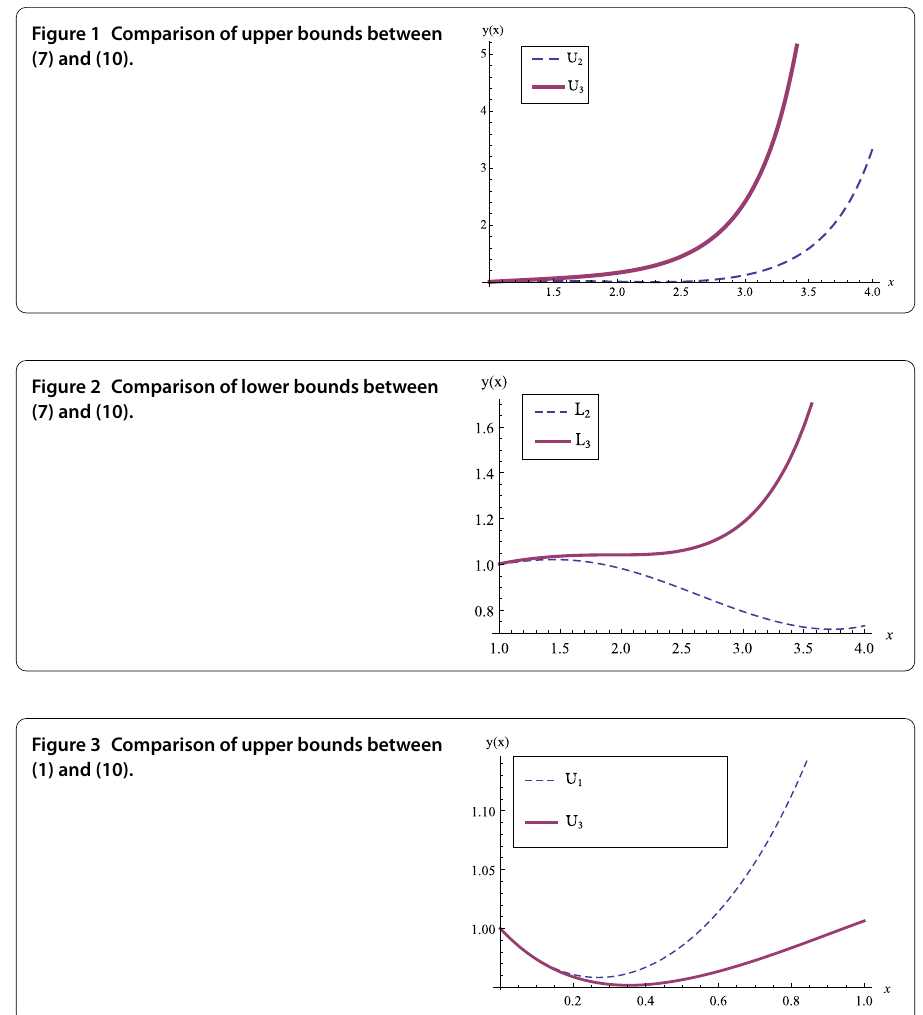
Figure 1 Comparison of upper bounds between (7) and (10).